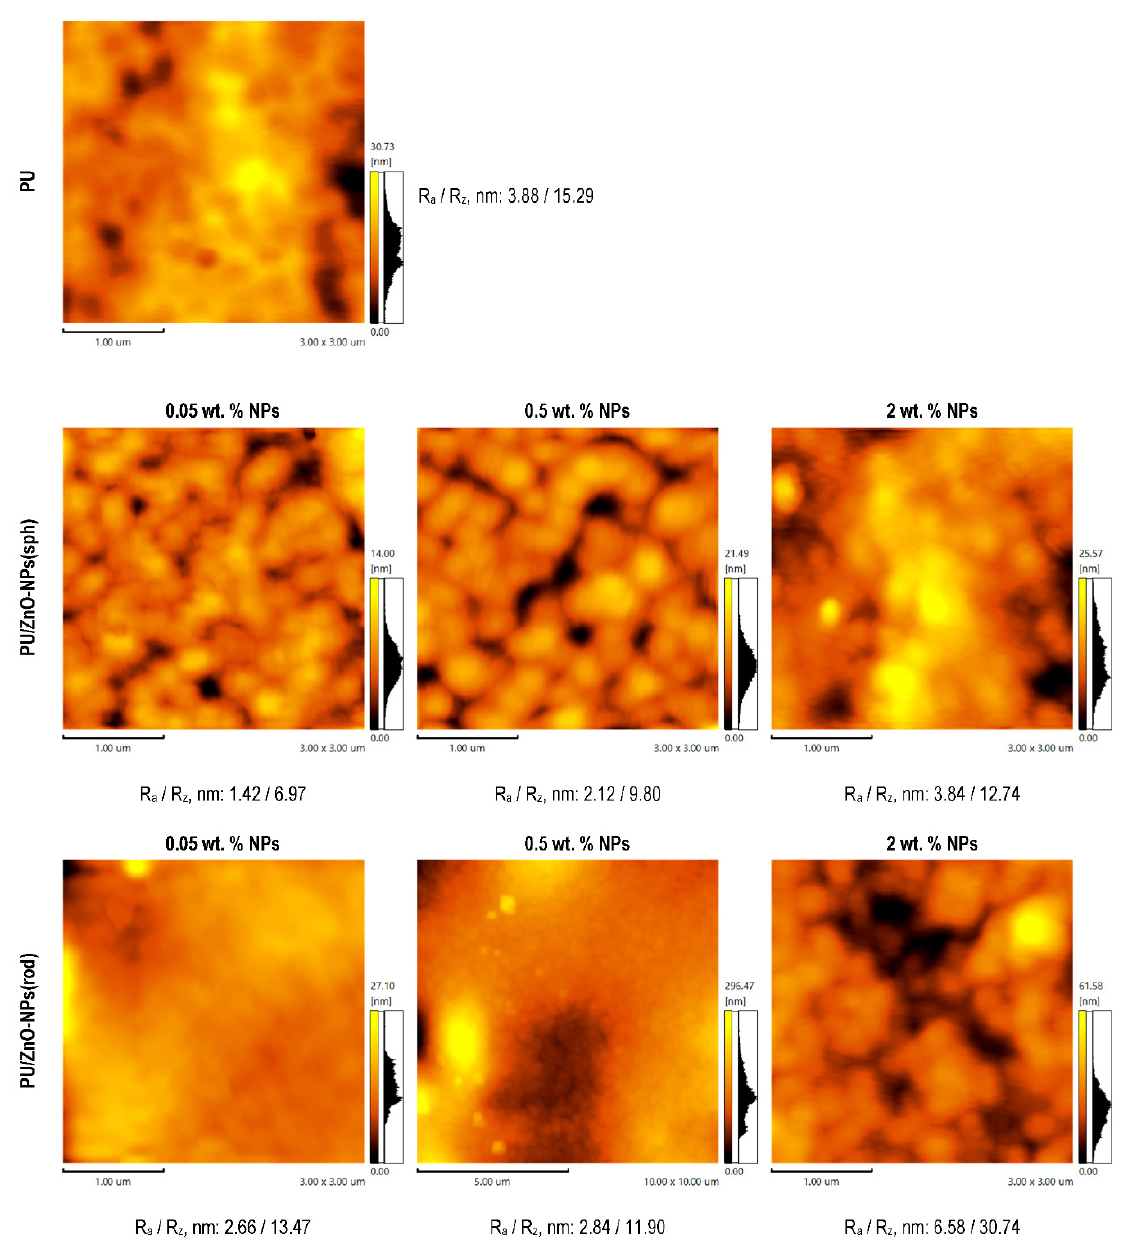
Figure 4. The AFM data of the membranes based on the various PU solutions with ZnO-NPs.